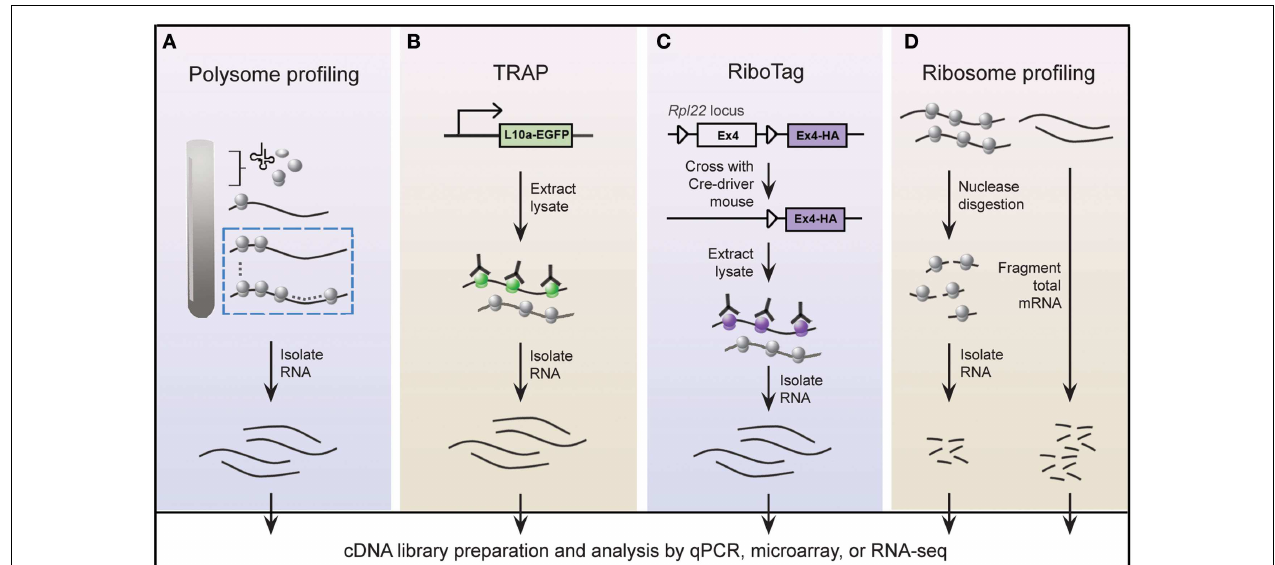
is crossed with a mouse expressing Cre-recombinase in a cell-type specific manner, Cre-recombinase activates expression of HA-tagged Rpl22, which incorporates into polysomes (purple ribosomes). Homogenized tissues from the offspring are subjected to co-immunoprecipitation using antibodies against HA, and associated mRNAs are identified by various techniques. (D) Using ribosome profiling to identify ribosome occupancy on mRNAs, cycloheximide-treated lysates from cultured cells are digested by micrococcal nucleases to remove mRNA sequences that are not bound by ribosomes (left).The resulting monosome complexes are purified by ultracentrifugation through a sucrose gradient or cushion. Ribosome-protected fragments are recovered and deep sequenced. In parallel, total mRNA from a similar preparation of cycloheximide-treated lysate is fragmented and deep sequenced (right), and serves as a normalizing